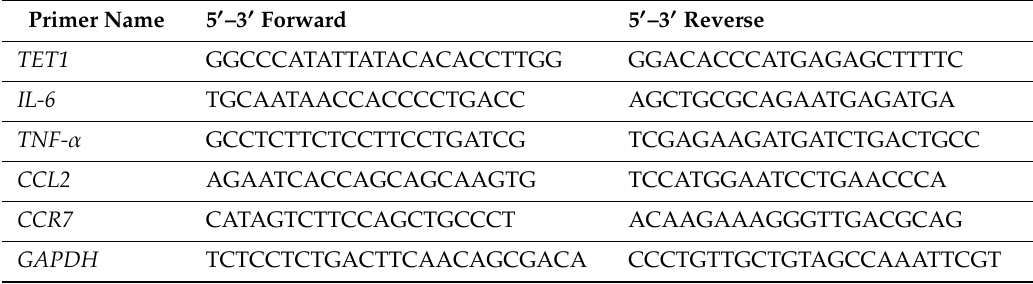
Table 2. Table of